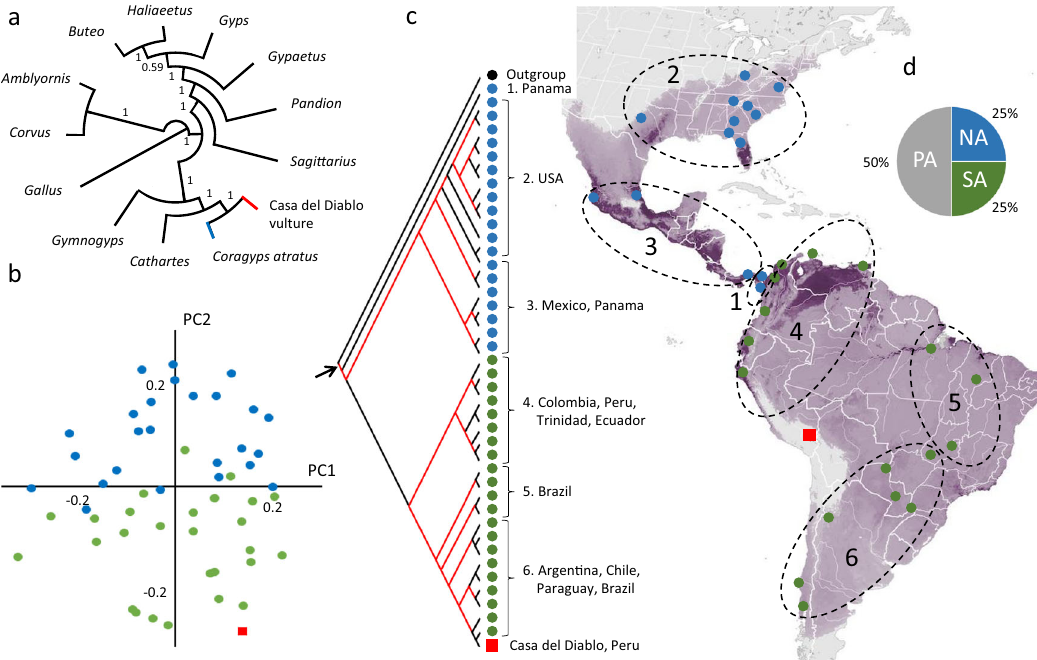
Fig. 2 Higher-level relationships of the genus Coragyps , and phylogenomic structure in Coragyps atratus . a Higher-level phylogeny based on 892 exonic alignments shows that occidentalis (red branch) is most closely related to the genus Coragyps (blue branch). b Principal component analysis of genotype likelihoods estimated from occidentalis and 52 individuals of atratus representing its entire geographic distribution. The cluster of atratus individuals from North and Central America (blue dots) shows only limited overlap with the cluster of South American individuals (green dots) along the PC2 axis. It is also clear that occidentalis (red square) is closest to the South American cluster. c Phylogenomic analysis of 42 individuals of Coragyps atratus and occidentalis (red square), rooted with the outgroup, Cathartes aura (black dot) based on 1179 intronic alignments (totaling 586 kbp). Red branches have a posterior probability >0.90. The map shows the distribution and abundance of Coragyps atratus (from https://science.ebird.org/ based on data in ref. 92 ). d Inferred ancestral areas for the basal node in Fig. 2c (marked with an arrow; PA Panama, NA North America, and SA = South